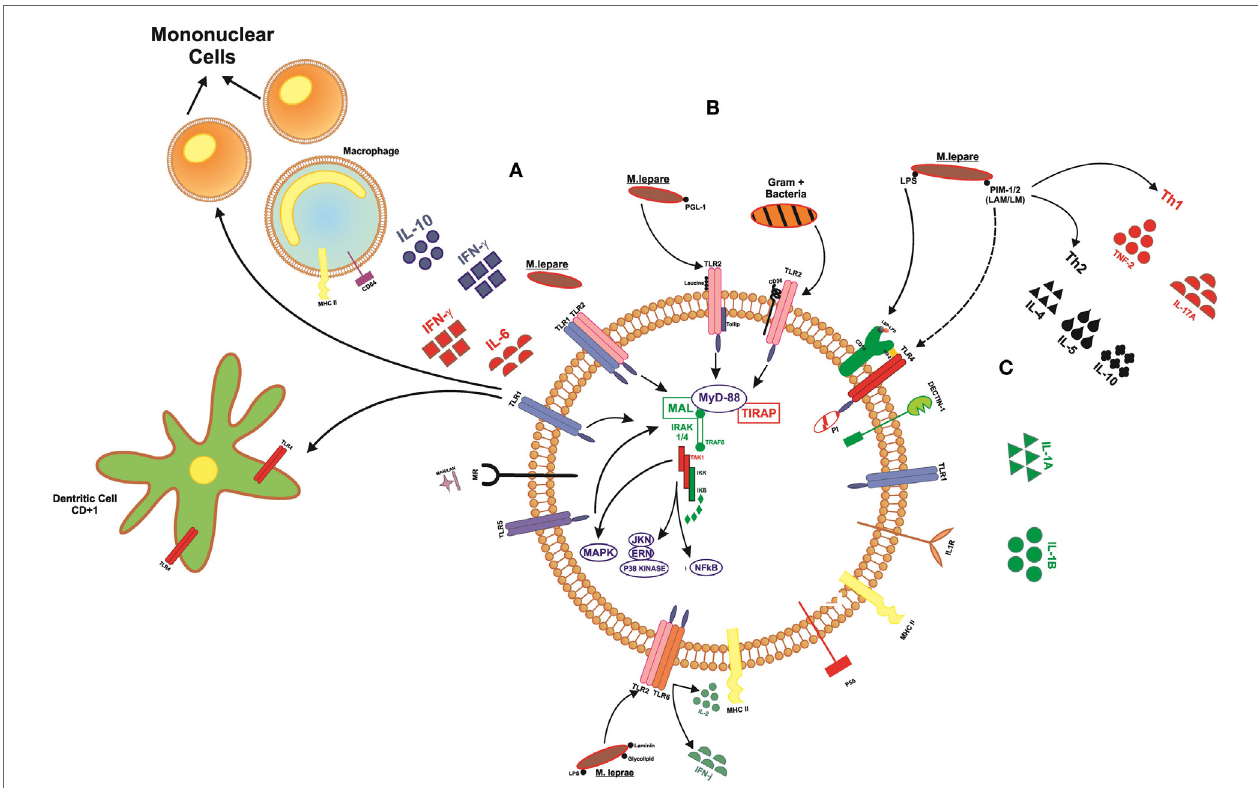
FiGURe 3 | Signaling toll-like receptors and interaction with cells of the immune system. (A) TLR1 acts on the differentiation of mononuclear cells into macrophages, releasing cytokines, such as IFN- γ and IL-6, whereas when activated, macrophages can release IFN- γ and IL-12. This receiver also operates in the maturation of dendritic cells, which become able to present the peptide to lymphocytes T. (B) TLR2 heterodimer with other markers, such as TLR1, TLR6, CD36, Dectin1, being able to recognize membrane components of bacteria Gram + and Gram − . (C) TLR4 forms a complex with MD2 in response to LPS. The marker CD14 binds to LPS. This LBP–LPS complex binds and releases the TLR–MD2 complex to initiate intracellular